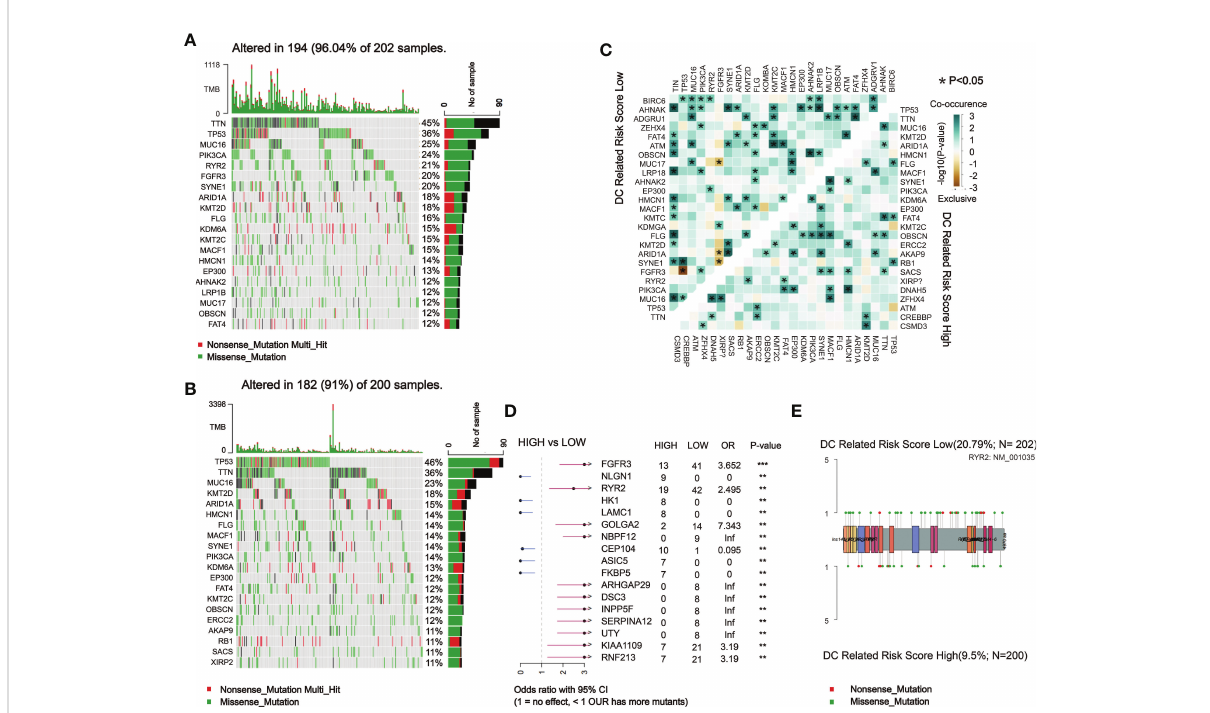
FIGURE 5 Landscape of somatic mutations between the DCRSL and DCRSH groups. (A, B) Waterfall plot of tumor somatic mutations established by those with low DC-related risk scores (n = 202) (A) and high DC-related risk scores (n = 200) (B) . (C) The heatmap shows the mutual co-occurring and exclusive mutations of the top 20 frequently mutated genes. The color or symbol of each cell represents the statistical signi fi cance of the exclusivity or co-occurrence of each pair of genes, respectively. Green represents mutual co-occurrence, and brown represents exclusive mutation. Asterisks indicate statistical p-values (*<0.05). (D) Forest plot of statistically signi fi cant mutant genes between the groups. Asterisks indicate statistical p-values (*<0.05, **<0.01, ***<0.001). (E) The lollipop plot illustrates the differential distribution of variants for ryanodine receptor 2